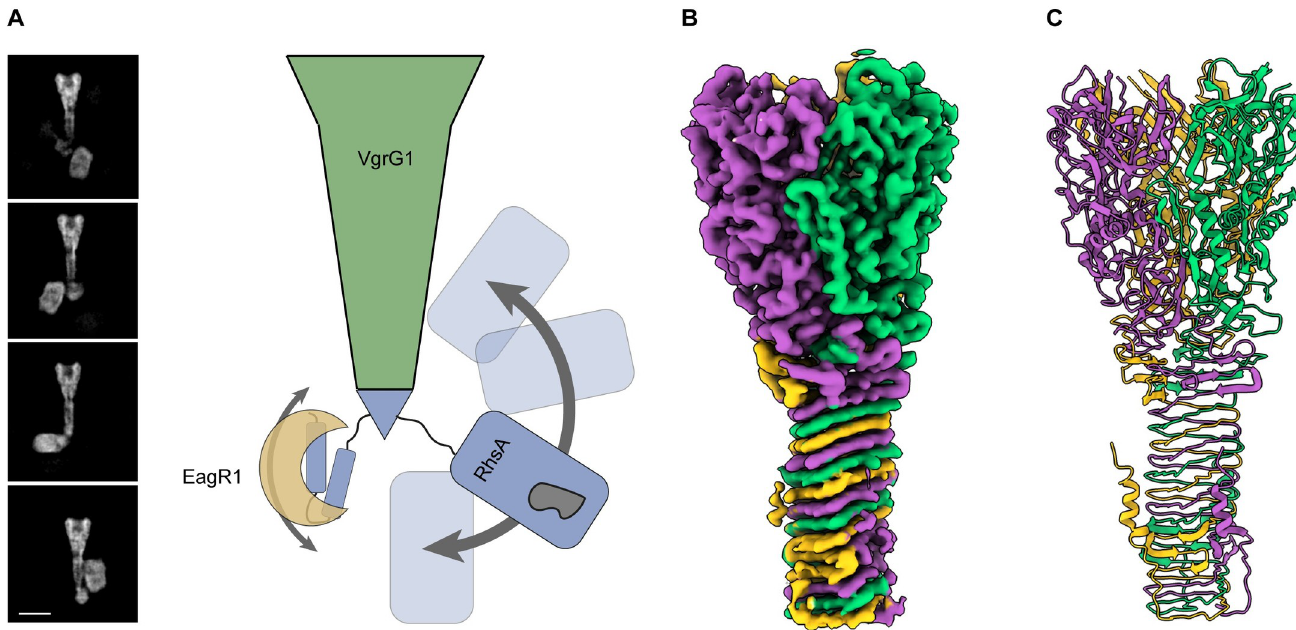
Fig 5. High-resolution structure of P . protegens VgrG1. (A) The RhsA barrel of the assembled pre-firing complex (PFC) displays high positional flexibility relative to VgrG1. Representative cryo-EM 2-D class averages depicting flexibility are shown. Scale bar, 10 nm. (B) Cryo-EM density and (C) ribbon representation of the molecular model of the P . protegens VgrG1 trimer viewed along the long axis of the protein. Each protomer is colored differently to highlight their positions within the homotrimeric VgrG1 spike.